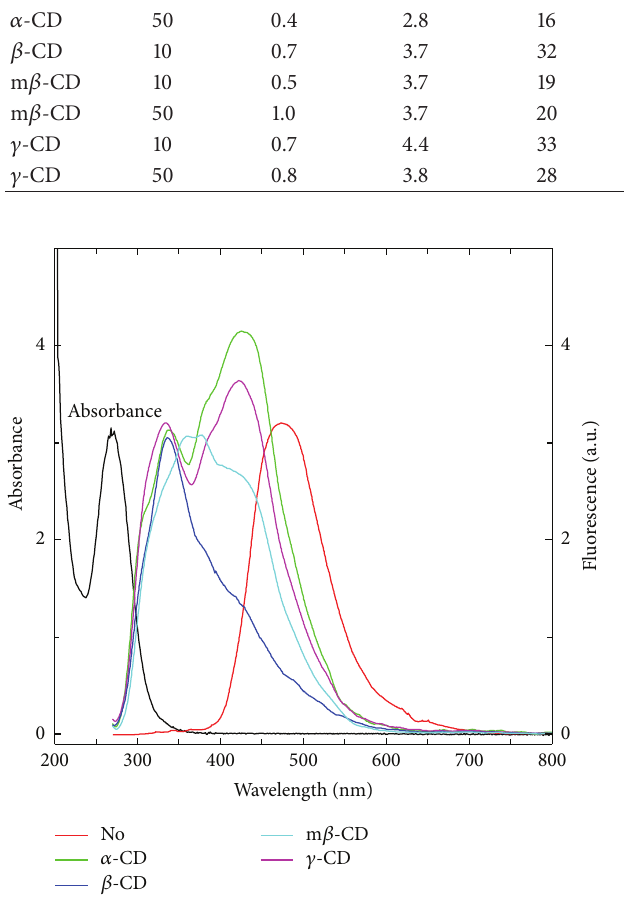
Figure 3: Absorption (black line) and fluorescence spectra of DE in the absence (red line, no CD, pure ACN solvent) and presence of 𝛼 - CD (green), 𝛽 -CD (blue), m- 𝛽 -CD (cyan), and 𝛾 -CD (magenta). All CD solutions were [10mM] in H 2 O/ACN (9:1).